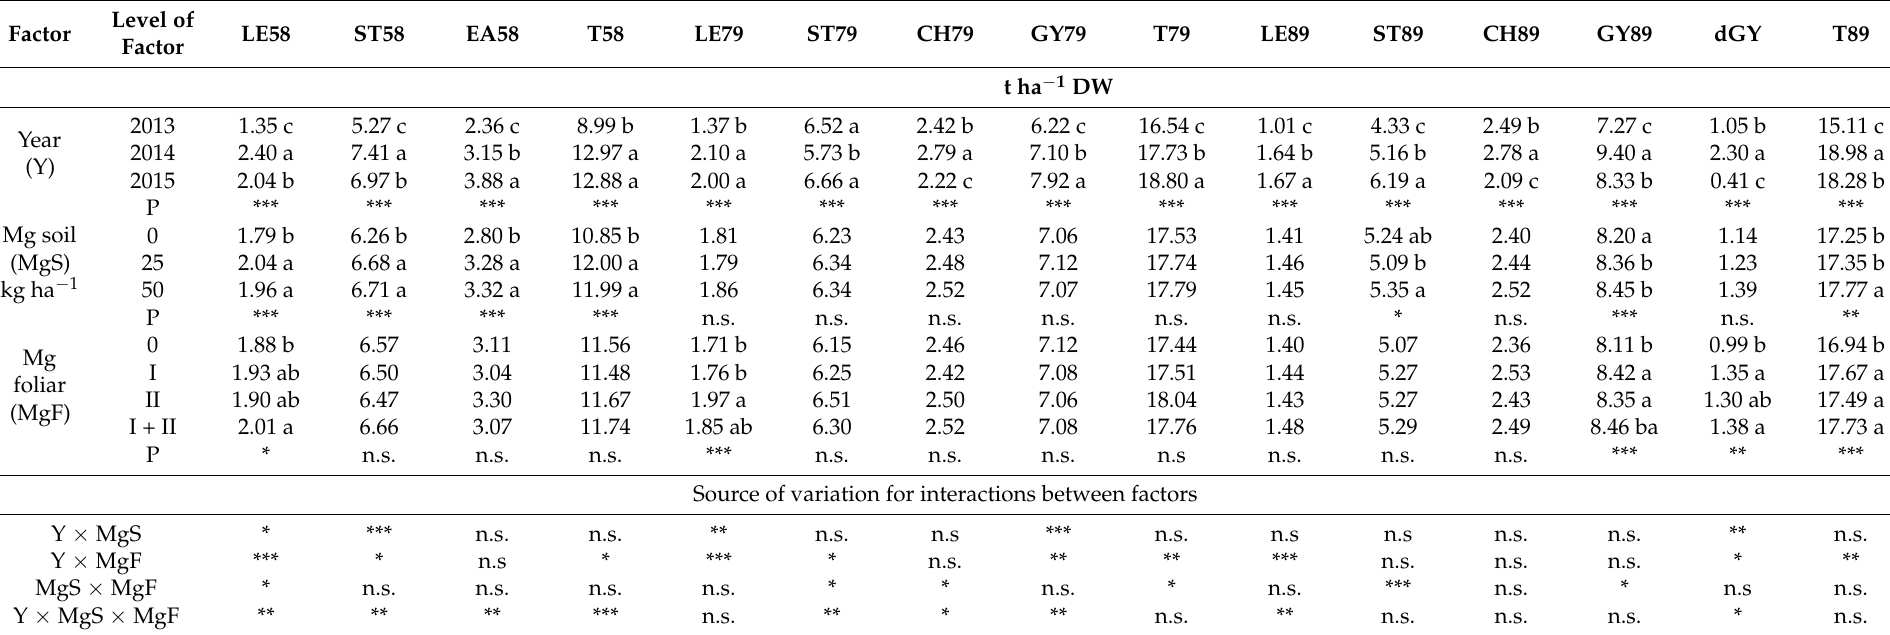
Table 4. Statistical evaluation of factors affecting wheat biomass at critical stages of the grain-filling